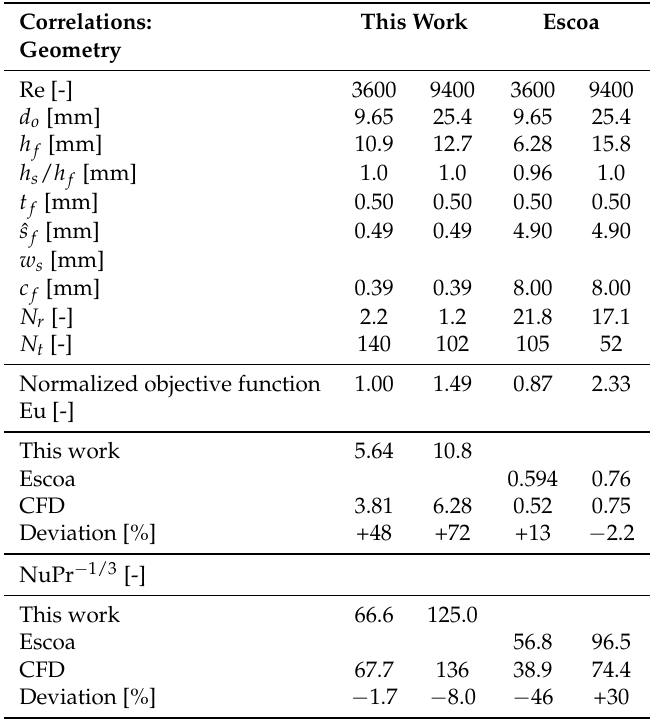
Figure 4. Optimized boiler geometry using the Escoa correlations ( left ) and correlations developed in this work ( right ), without explicit diameter constraints Table 5. Case study: Geometry optima for correlations from this work and Escoa, without (left column) and with explicit diameter constraint of 25.4 mm (right column). Eu and NuPr − 1/3 data are computed at the closest geometry possible to simulate with